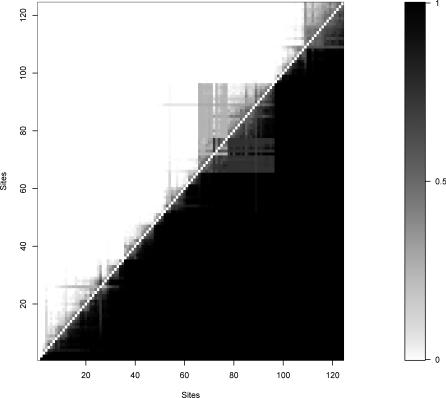
The Pair-Order Matrix Oij = P(π(i) < π(j)) between Sites for Dataset nt = 10, ns = 10 from the Eight Chains with the Best LikelihoodBlack denotes probability one, and white denotes probability zero. For most pairs, the probability is close to zero or one, but some blocks of observations have many different orderings with high probability.